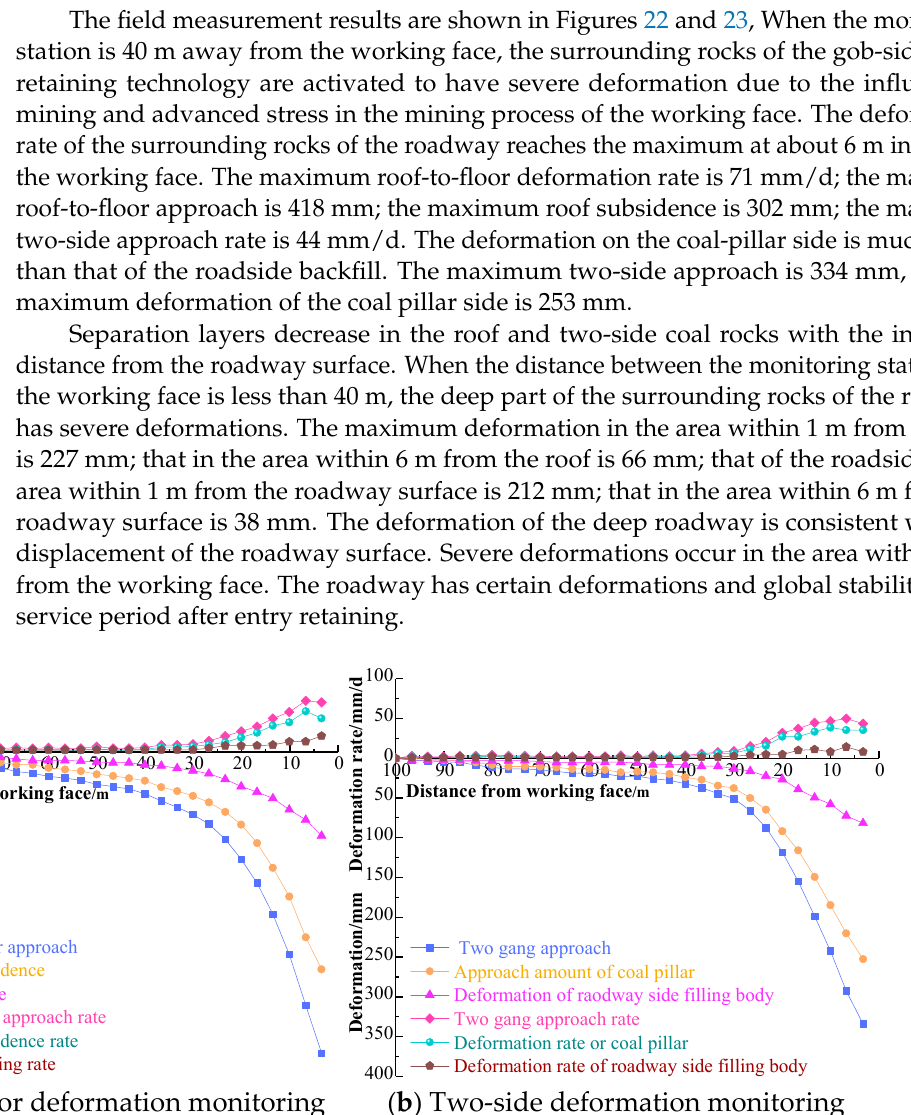
( b ) Internal displacement monitoring of coal pillar Figure 23. Deep displacement monitoring of gob-side entry-retaining technology. Separation layers decrease in the roof and two-side coal rocks with the increased dis- tance from the roadway surface. When the distance between the monitoring station and the working face is less than 40 m, the deep part of the surrounding rocks of the roadway has severe deformations. The maximum deformation in the area within 1 m from the roof is 227 mm; that in the area within 6 m from the roof is 66 mm; that of the roadside in the area within 1 m from the roadway surface is 212 mm; that in the area within 6 m from the roadway surface is 38 mm. The deformation of the deep roadway is consistent with the displacement of the roadway surface. Severe deformations occur in the area within 40 m from the working face. The roadway has certain deformations and global stability in the service period after entry retaining.